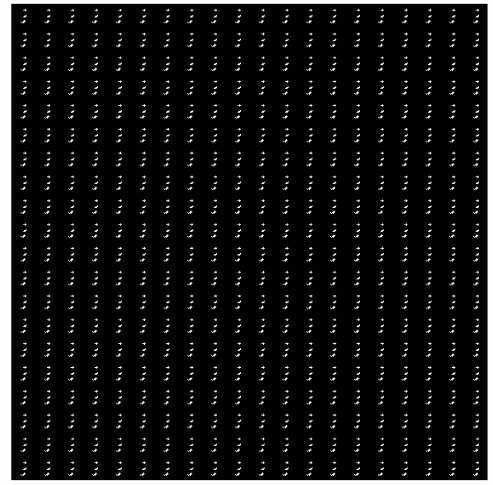
Figure A1. Collapsed